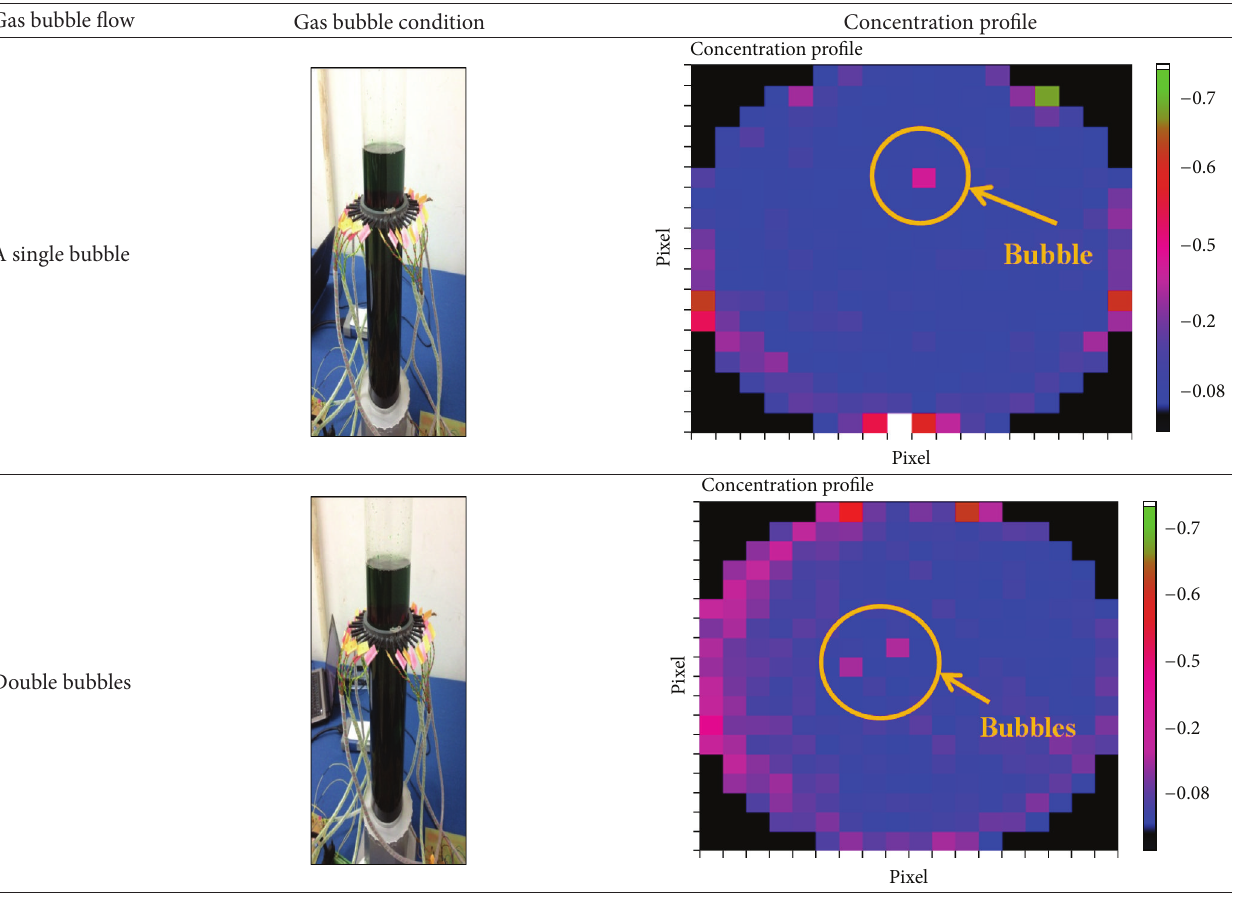
Table 3: The gas bubble condition and concentration profile for a single bubble and double bubble in contaminated water.